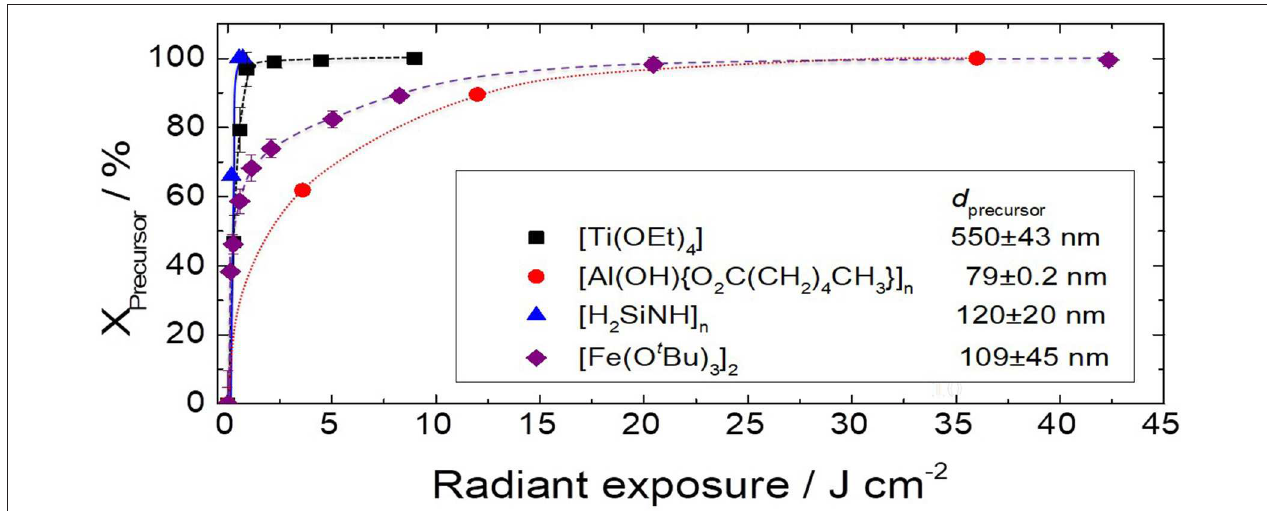
FIGURE 4 | Comparison of VUV-induced (Xe 2 * excimer irradiation, in a nitrogen atmosphere with 0.25 vol% O 2 ) decomposition of different metal-organic precursor thin films depending on the applied radiant exposure at 1 bar and ≤ 34 ◦ C (Prager et al., 2007; Wennrich et al., 2013; With et al., 2016, 2019b).